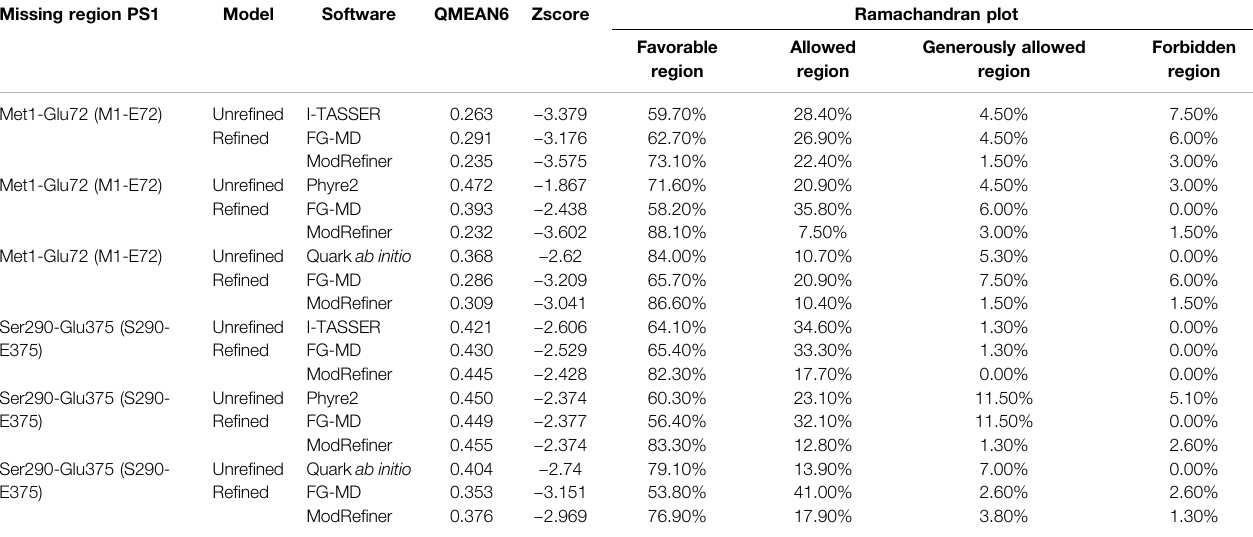
TABLE 1 | Energetic and stereochemical validation of missing fragments of PS1 protein. Missing region